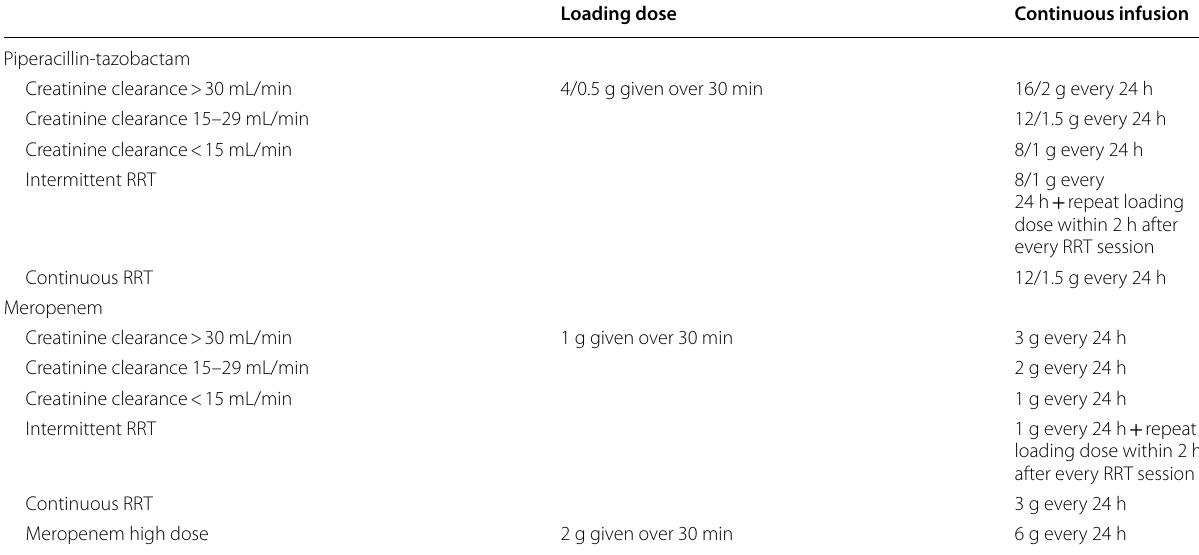
Table 1 Dosing regimens for piperacillin-tazobactam and meropenem according to renal